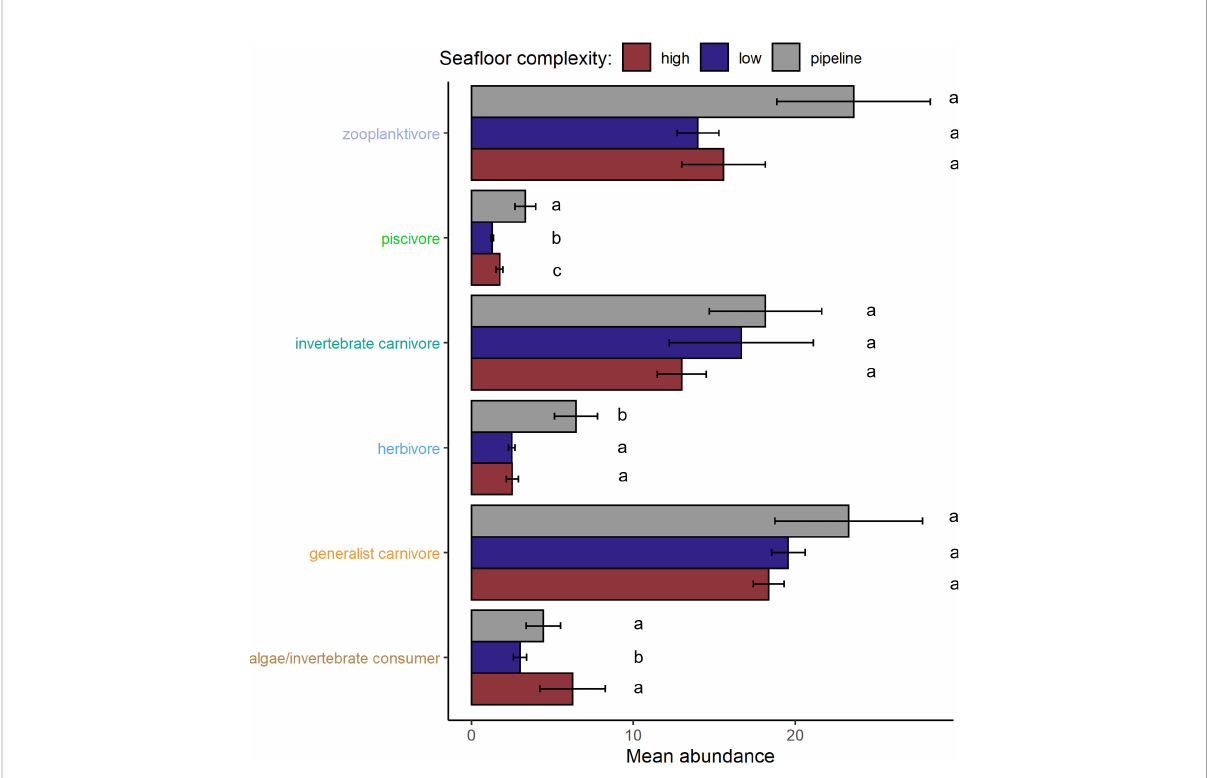
FIGURE 2 Mean (± SE) abundance fi sh per BRUV deployment for fi sh six feeding guilds represented on the vertical axis and between sea fl oor complexities: pipelines, low complexity natural habitat and high complexity natural habitat. Statistically similar means are indicated by the same letter (e.g., a/